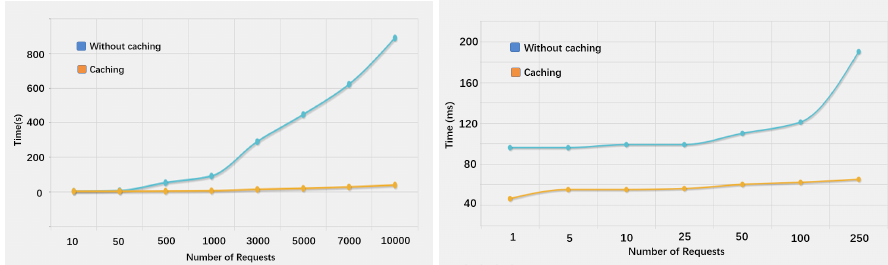
Fig. 6. Performance study and comparison with/without data